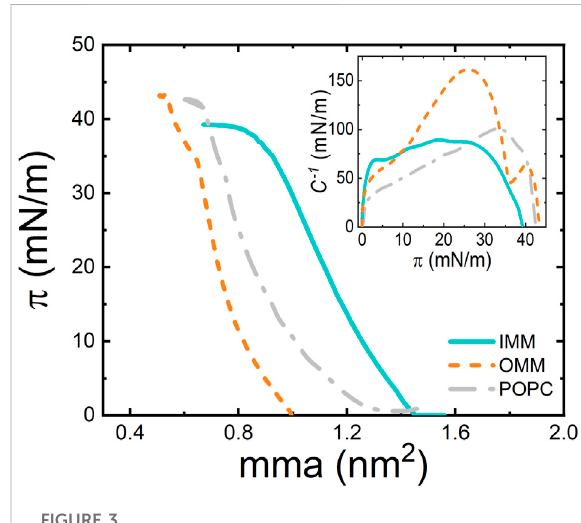
FIGURE 3 π − A isotherm of POPC, OMM, and IMM lipid monolayers at 22 ° C and at compression rate of 10 cm 2 /min. (Inset) Compressibility modulus, C − 1 , of POPC, OMM, and IMM lipid extracts as a function of the surface